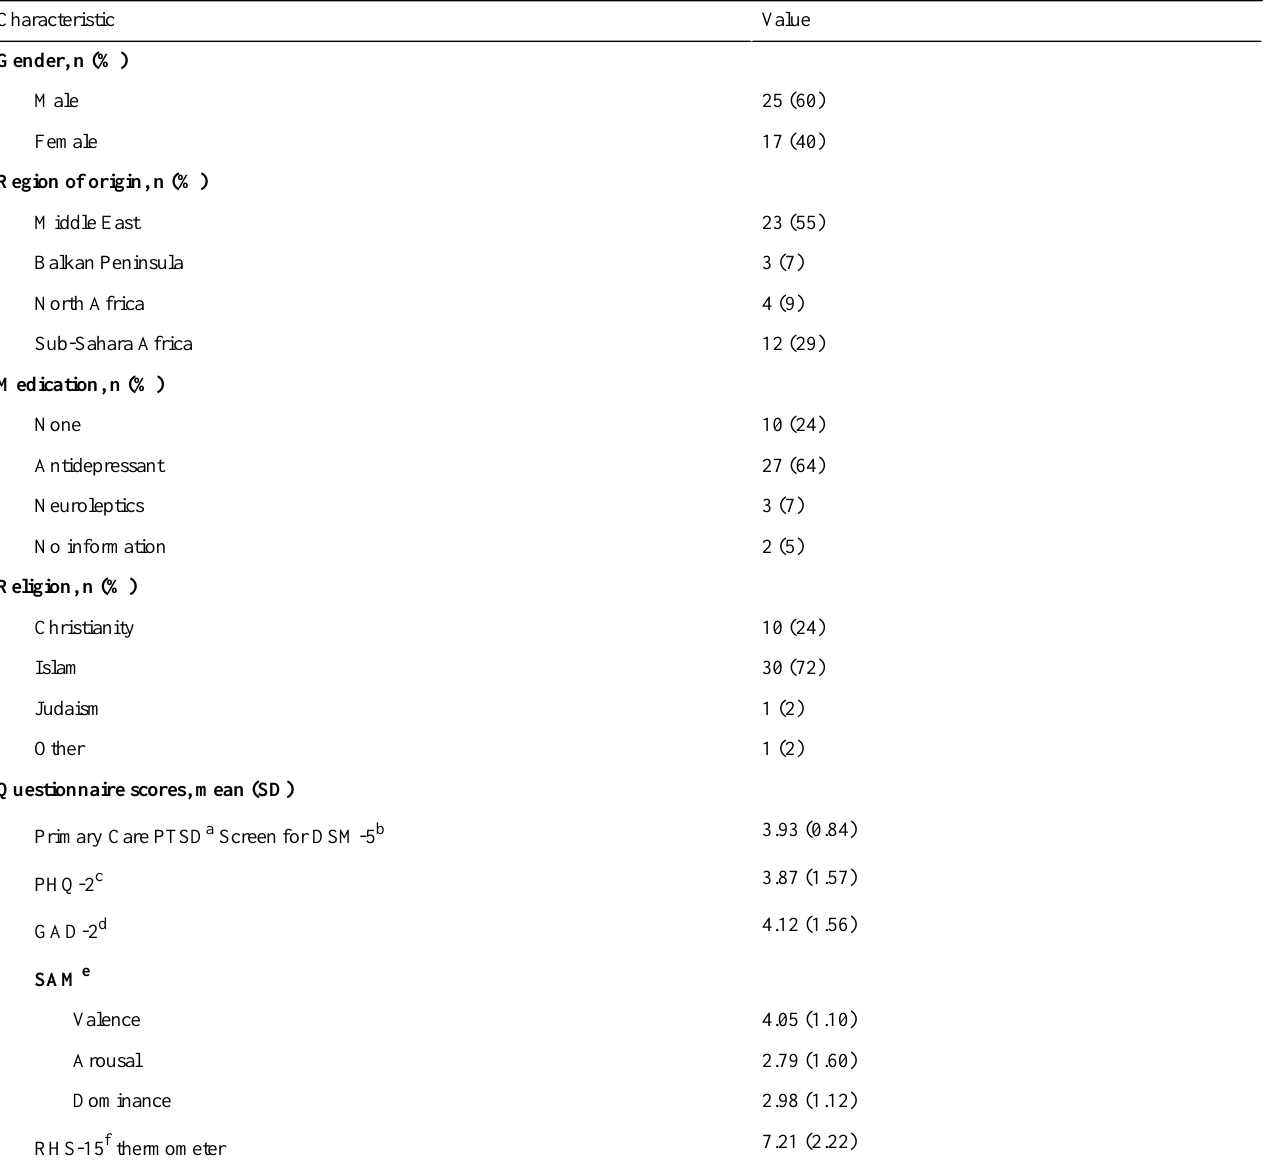
Table 1. Sociodemographic characteristics and measurement at baseline for all participants